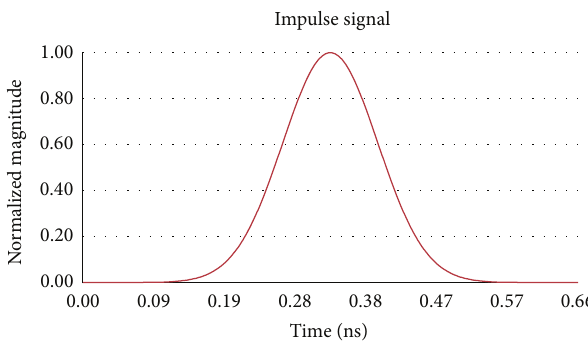
Figure 3: Transmitted Gaussian impulse signal.